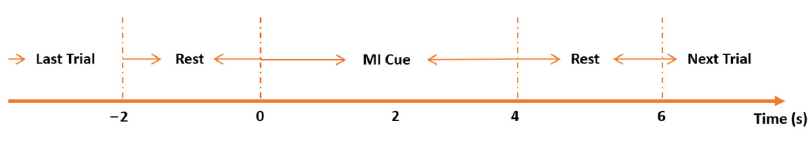
Figure 2. Overview of the methodology used in the present work.